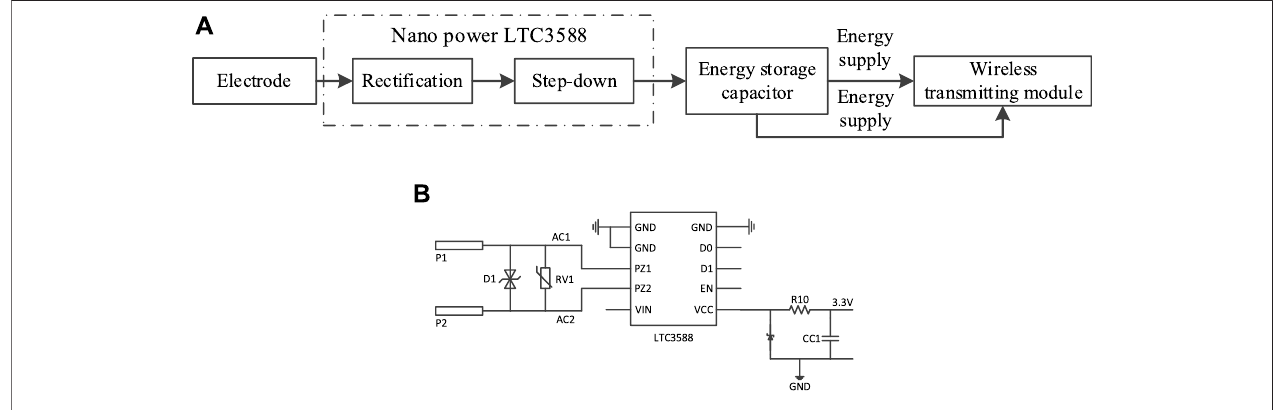
FIGURE 2 | Device construction. (A) Overall structure of the self-powered step voltage early warning device and (B) energy collection circuit.